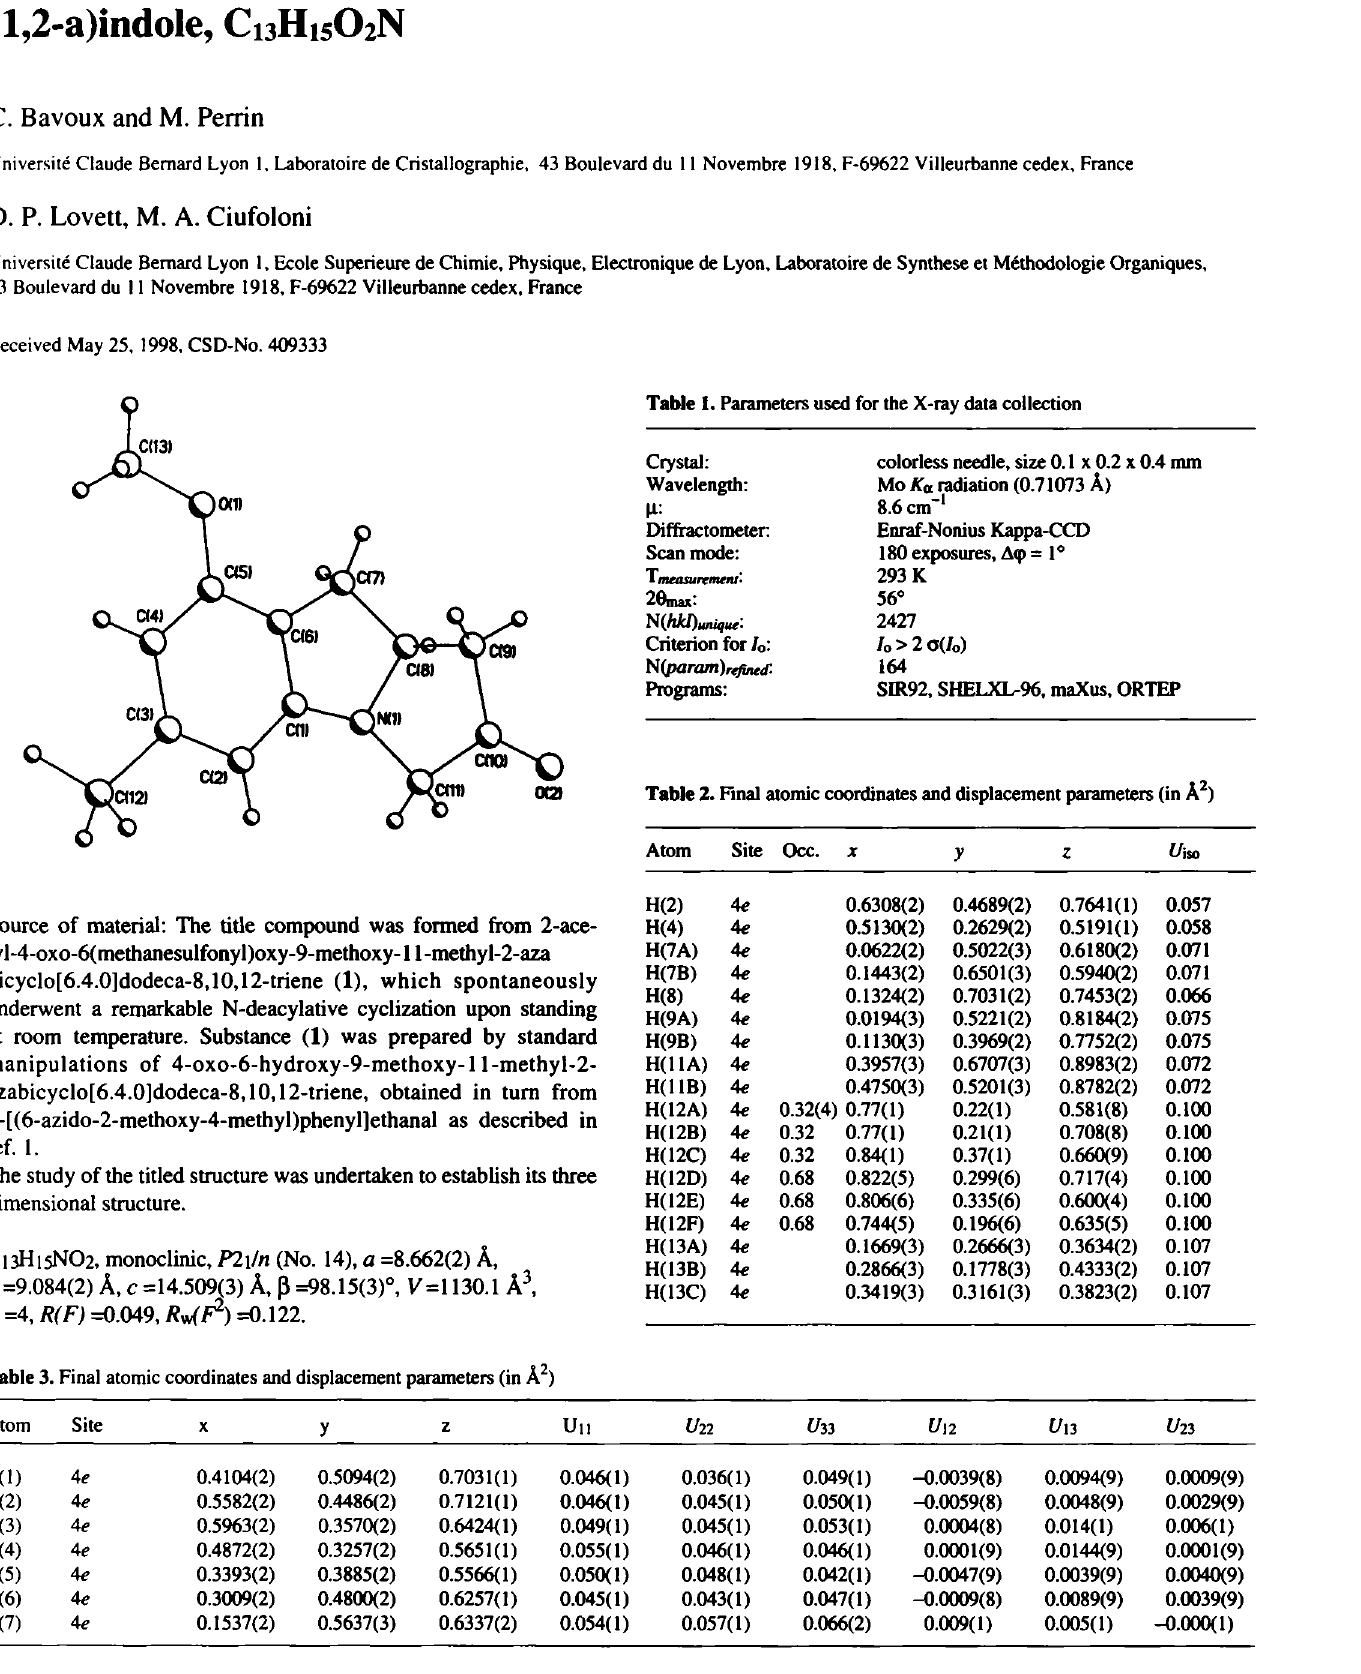
Table 3. Final atomic coordinates and displacement parameters (in Â^)